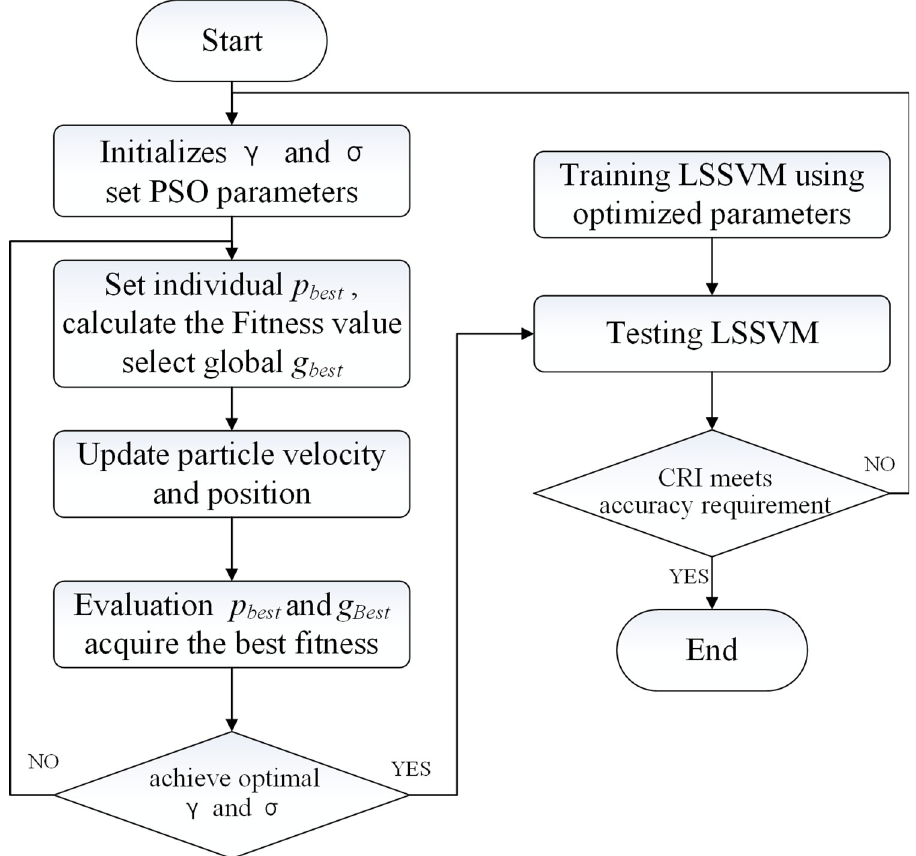
Fig 4. The flow of CRI acquisition by